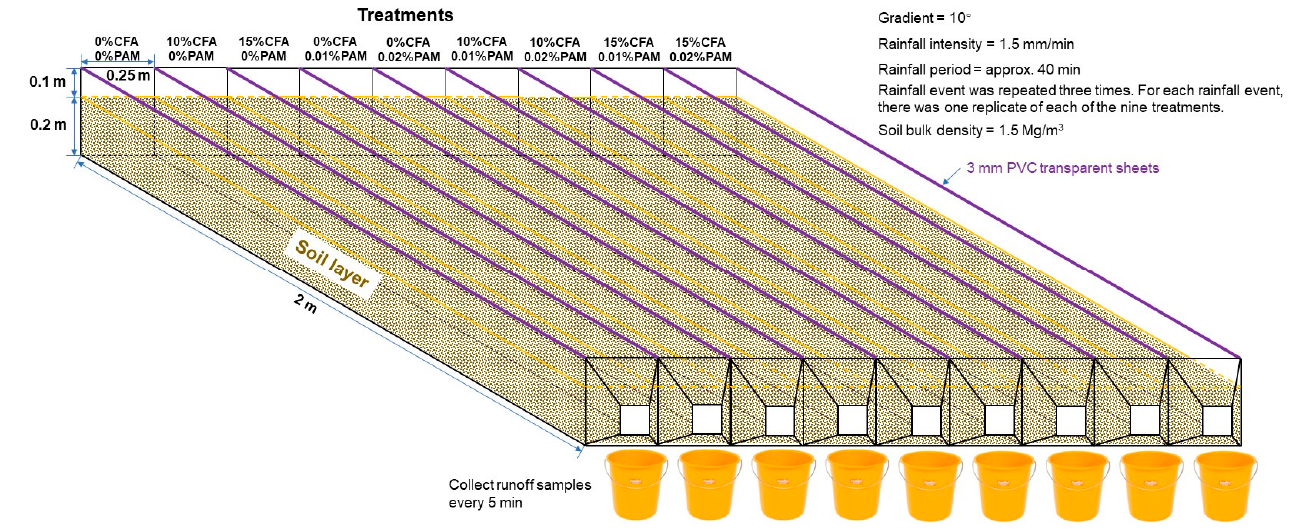
Figure 1. Diagram of the experimental apparatus and treatment plots.